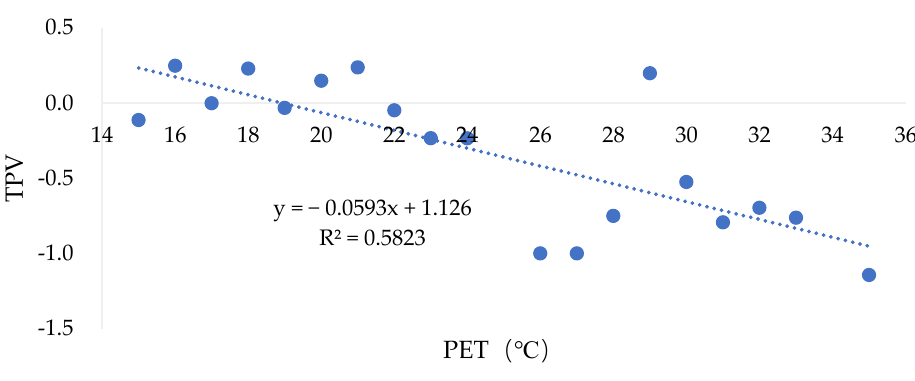
Table 8. Independent sample t-test for gender on weather perception.